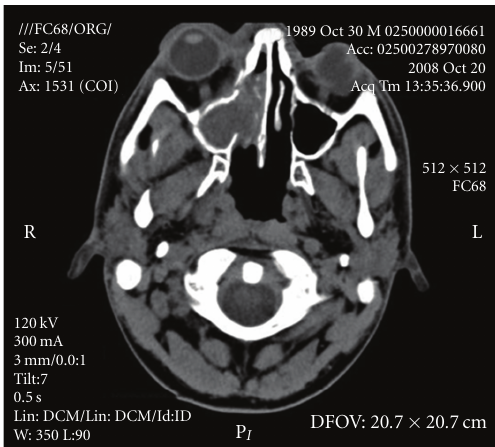
Figure 2: CT scan of the perinasal sinuses: infiltrative lesion of the perinasal sinuses that exerts compression on the right optic